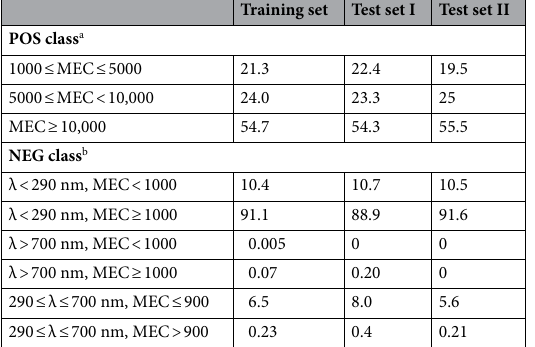
Table 1. Distribution of UV–Vis absorption features in the data sets (MEC values in Lmol −1 cm −1 ). a Statistics concerning the peak with the highest MEC within the 290–700 nm window; b statistics concerning any listed